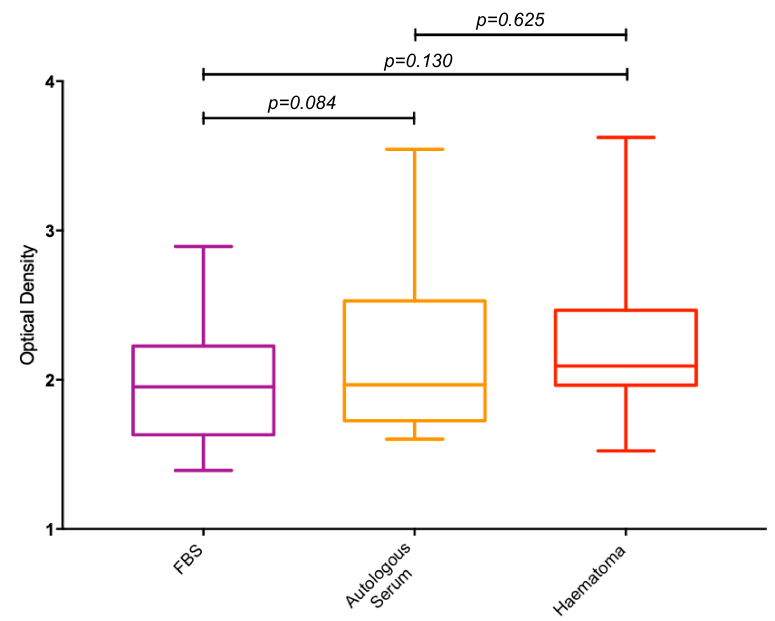
Figure 2. Box plots showing the ratio, expressed as a percentage, of optical densities measured from the XTT proliferation assay between FBS, autologous serum and fracture haematoma. FBS = Foetal Bovine Serum.